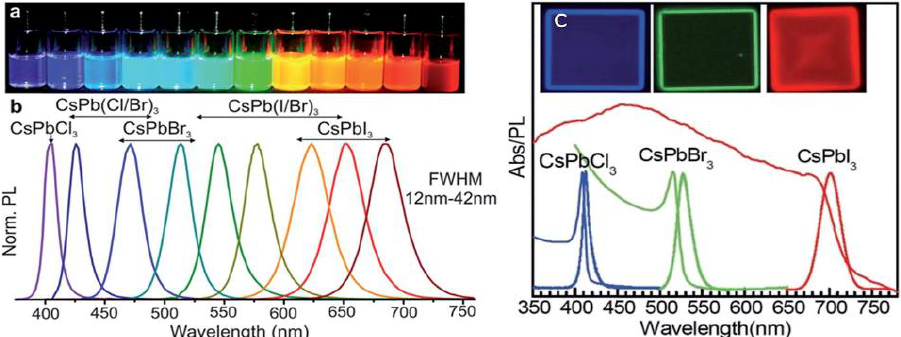
Figure 2. ( a ) Colloidal CsPbX 3 NCs (X = Cl, Br and I) in toluene under UV lamp ( λ = 365 nm); ( b ) corresponding PL spectra ( λ exc = 400 nm for all but 350 nm for CsPbCl 3 NCs); ( c ) optical absorption, PL spectra and inset images for CsPbCl 3 , CsPbBr 3 and CsPbI 3 nanoplatelets. Reprinted with permission [49,50]. Copyright 2016, John Wiley & Sons and 2015, American Chemical society.